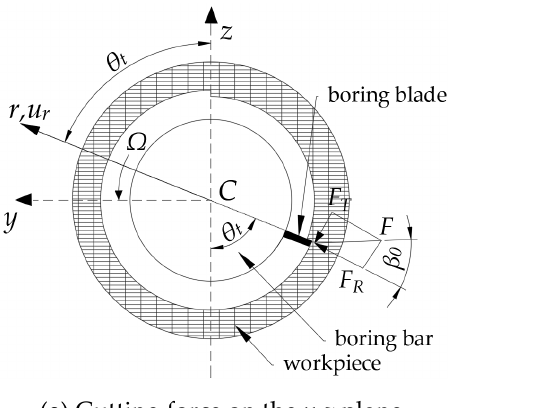
f and f denote the cutting forces along the y -axis and z - y z